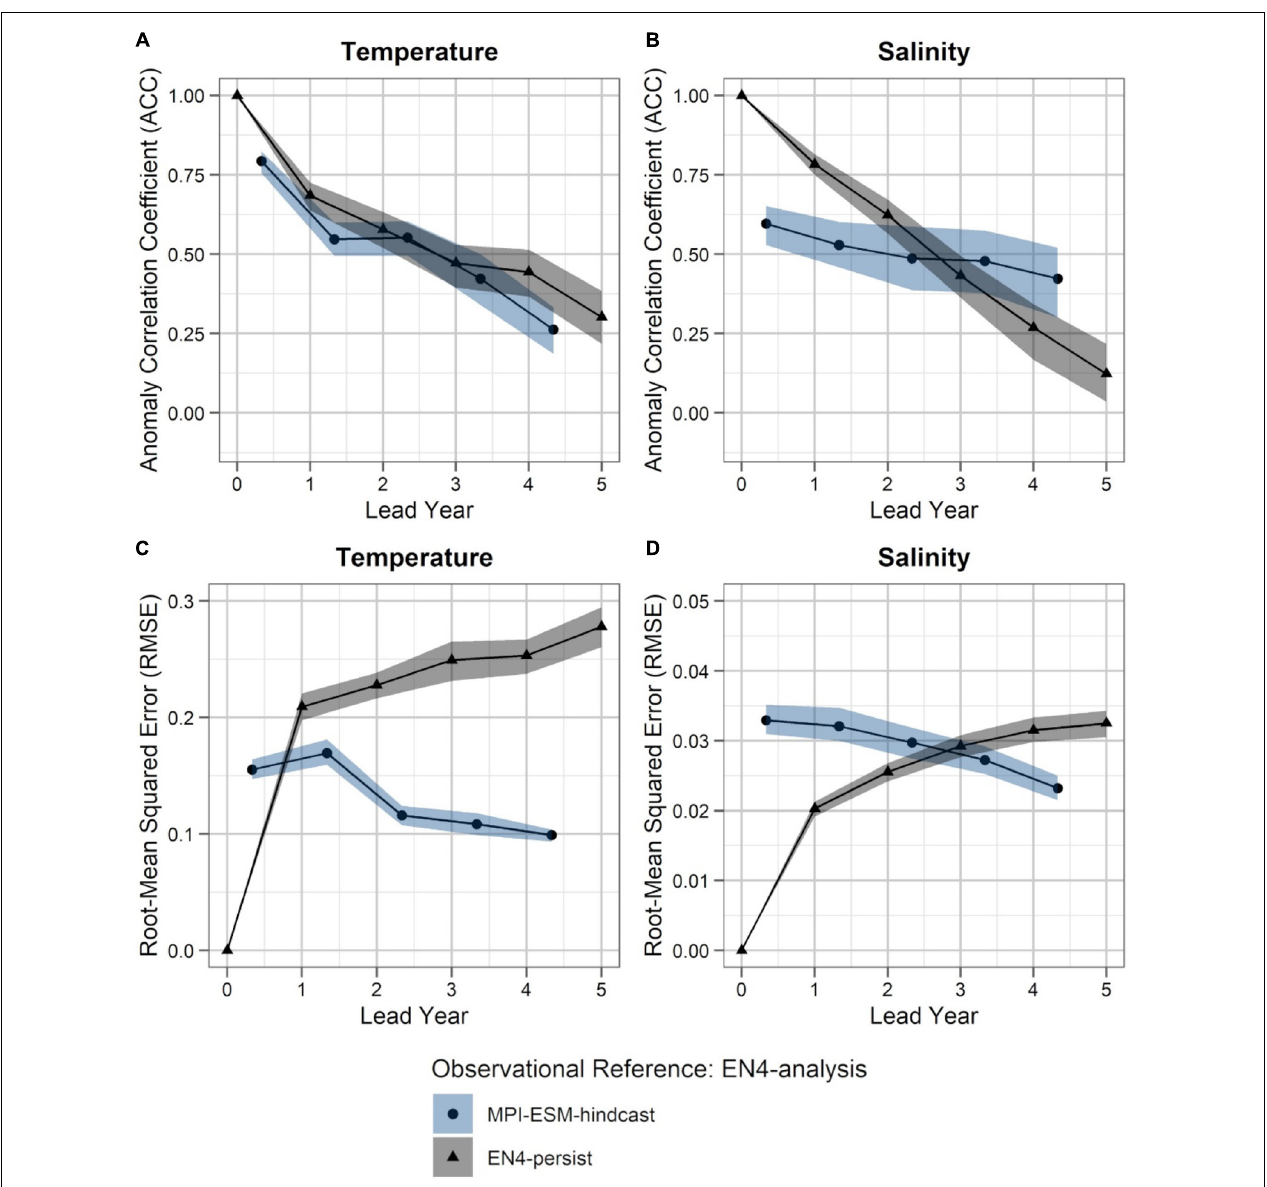
FIGURE 5 | Predictability of temperature (left; A,C ) and salinity anomalies (right; B,D ) averaged over 250–600 m in FMA within the spawning region (black rectangle in Figure 1 ), measured in terms of the anomaly correlation coefficient (ACC; top row) and root-mean squared error (RMSE; bottom row) of MPI-ESM-hindcast (bullet; blue area) and EN4-persist (triangle; grey), judged against EN4-analysis . The connected bullets/triangles indicate the median and the blue/grey shaded areas indicate spread based on the lower and the upper quartile of a 500-fold bootstrap. Two correlations (or RMSEs) are markedly different when their respective shaded areas show no